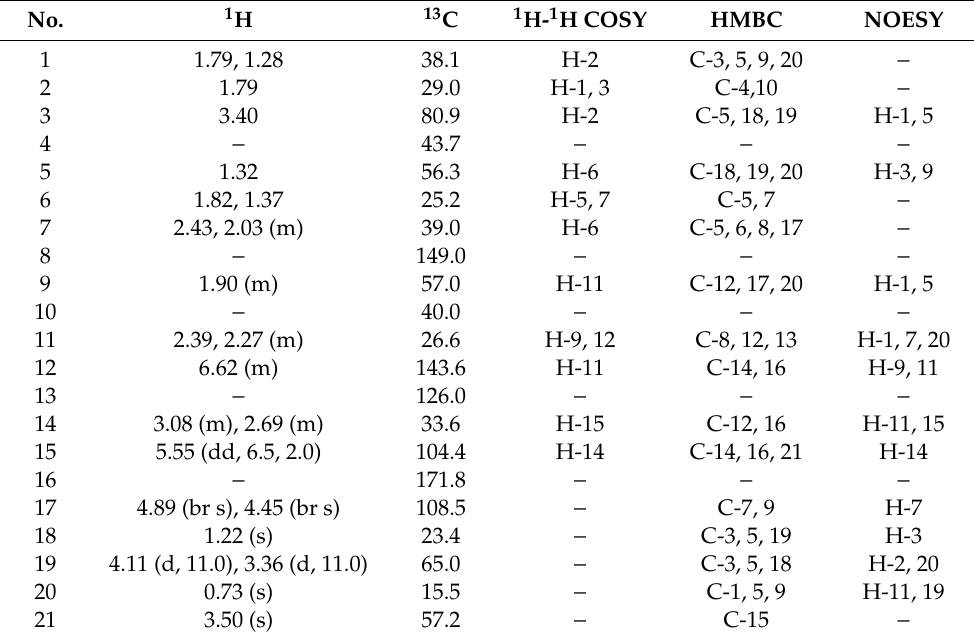
Table 2. NMR data of AP-4 (CD 3 OD, δ , J in Hz) 1 .